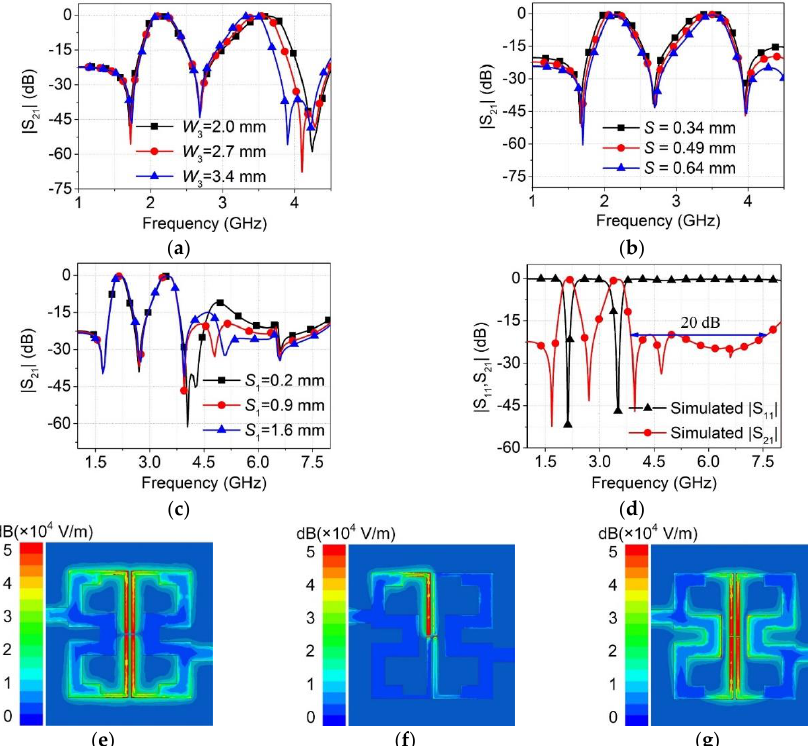
Figure 4. Simulation of dual-wideband bandpass filters (BPF). ( a ) The simulated | S 21 | response of the filter for various widths of W 3 ; ( b ) The simulated | S 21 | response of the filter for various widths of S ; ( c ) The simulated | S 21 | response of the filter for various widths of S 1 ; ( d ) Simulated | S 21 , S 11 | response of the dual-wideband BPF; ( e ) The simulated electric fields distributions of the dual-wideband BPF at 2.14 GHz; ( f ) The simulated electric fields distributions of the dual-wideband BPF at 2.68 GHz; ( g ) The simulated electric fields distributions of the dual-wideband BPF at 3.5 GHz.